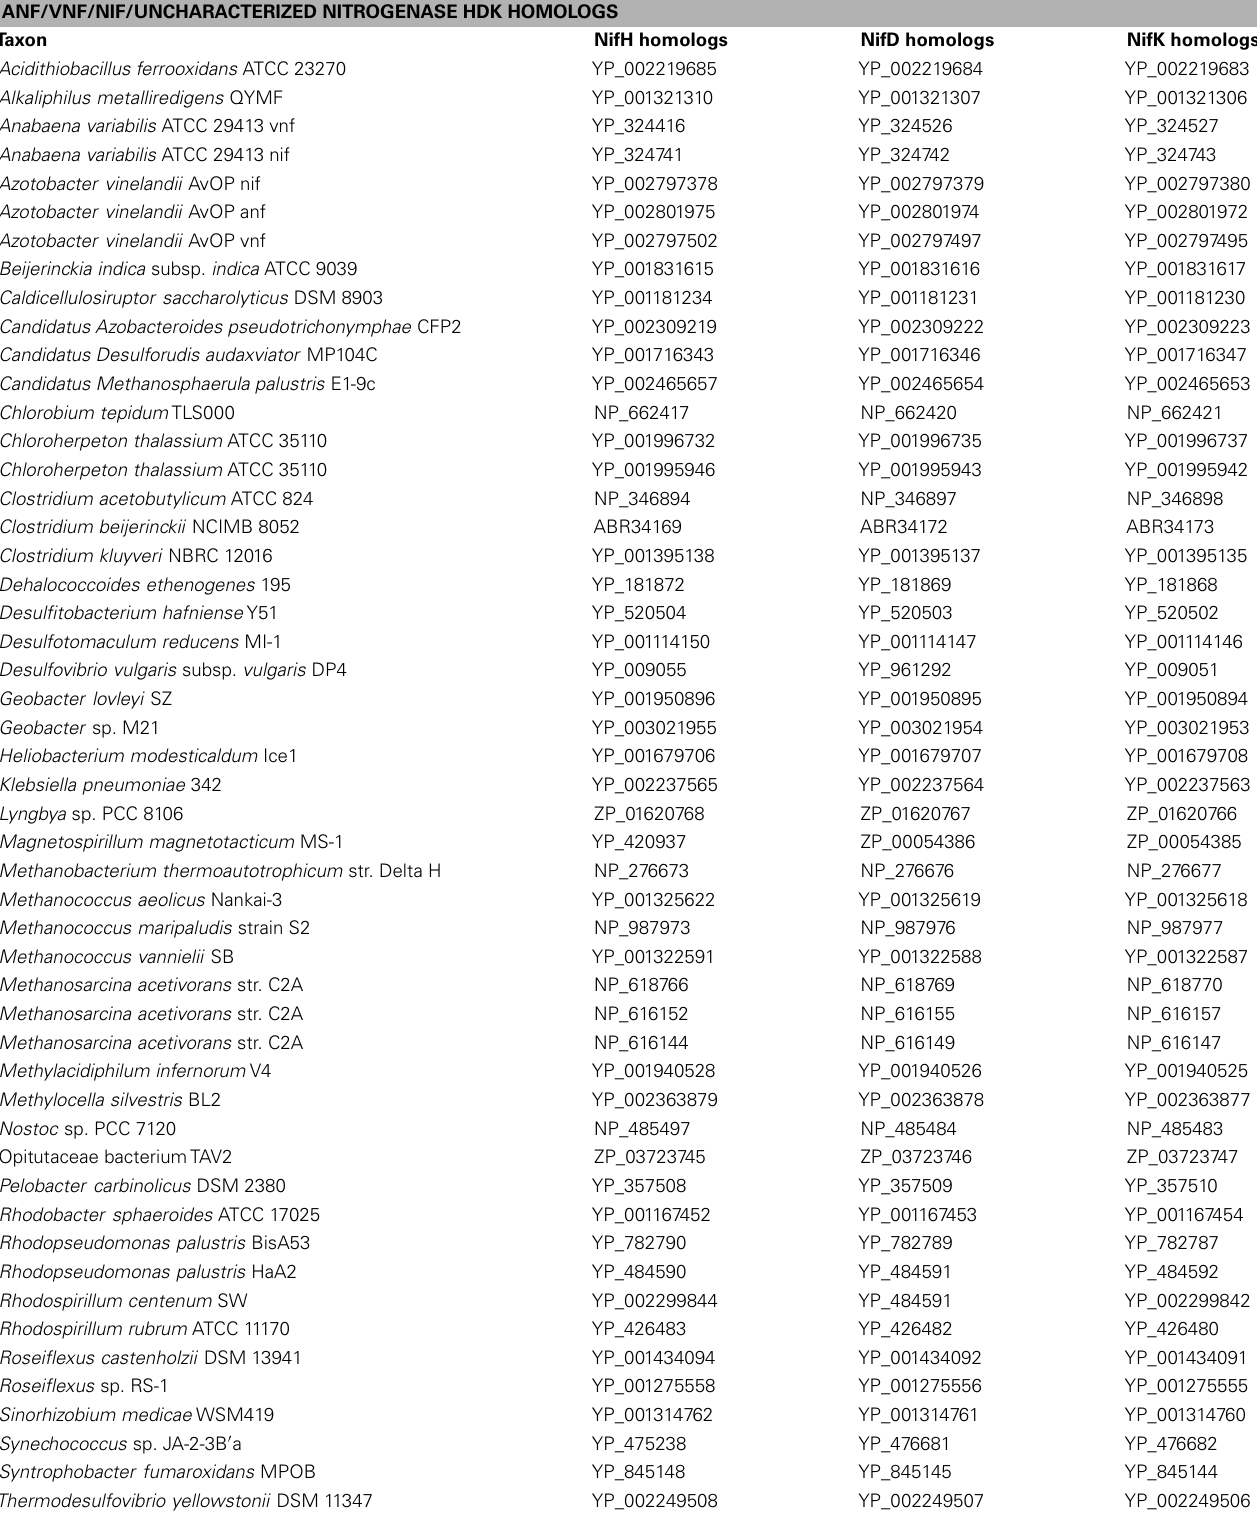
TableA1 |Accession numbers of representative sequences used in the present study. ANF/VNF/NIF/UNCHARACTERIZED NITROGENASE HDK